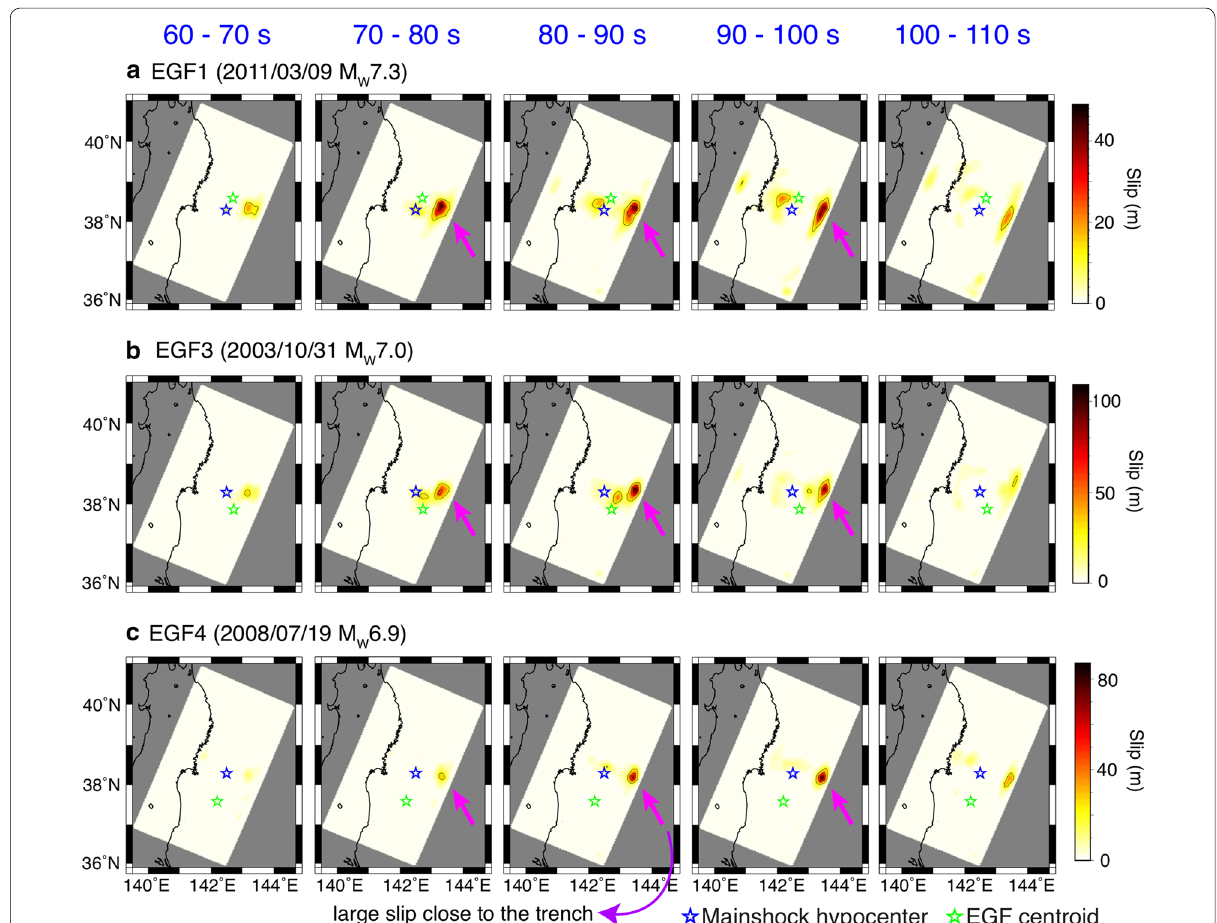
Fig. 7 Comparison of the spatiotemporal slip distribution using different EGFs for the Tohoku‑Oki Earthquake. As in Fig. 3, but for the spatiotemporal slip distributions in each 10‑s interval for the Tohoku‑Oki Earthquake using a EGF1 (09 Mar 2011, M W 7.3 ), b EGF3 (31 Oct 2003, M W 7.0 ), and c EGF4 (19 July 2008, M W 6.9 ). Pink arrows indicate notable slip features close to the trench (see “The 2011 M Earthquake” section for further